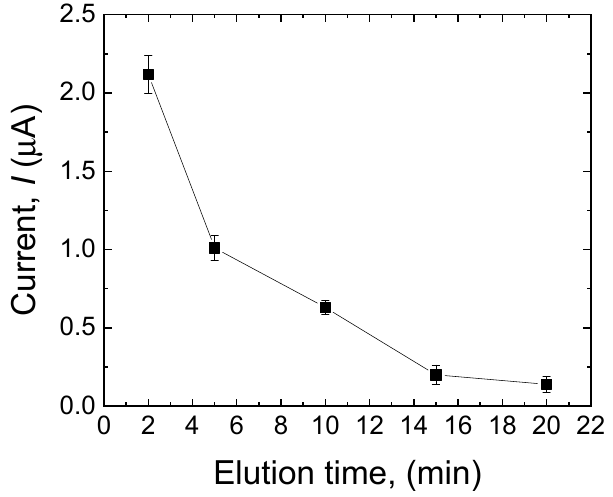
Figure 5. Effect of elution time (2 min, 5 min, 10 min, 15 min, and 20 min) on the current response of the sensor to MDA in the MIP layer. Error bars are calculated from three independent replicates.